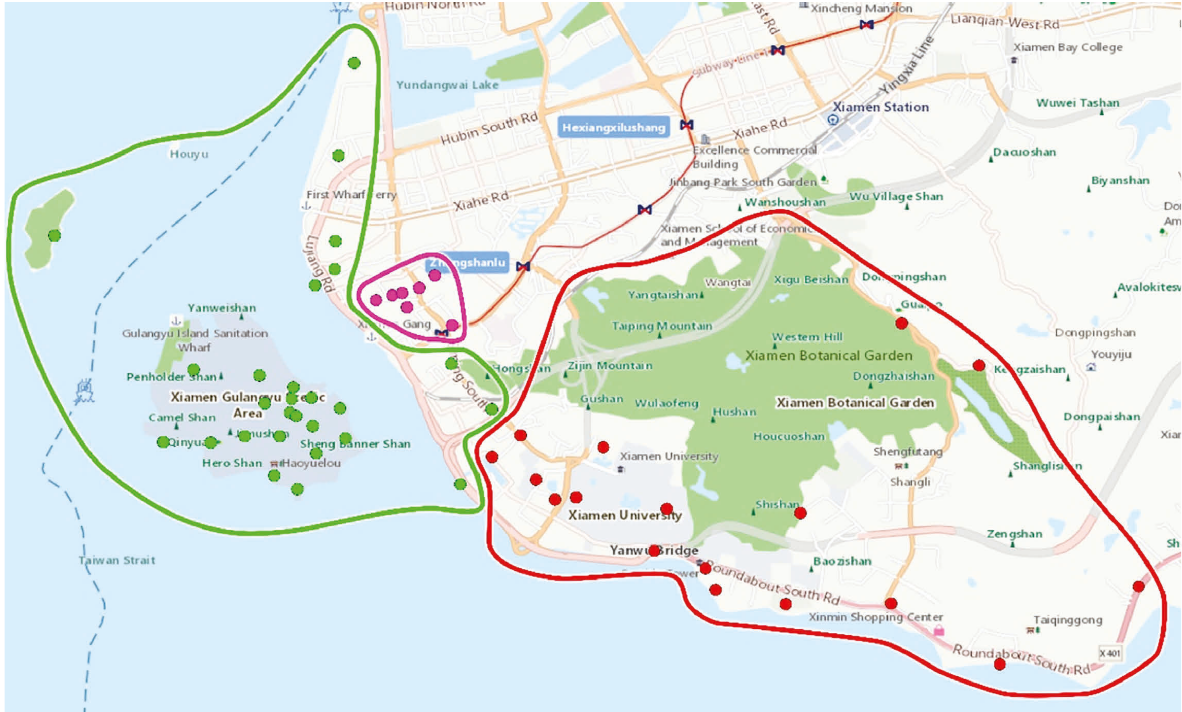
Figure 6: Identified tourism areas on the city